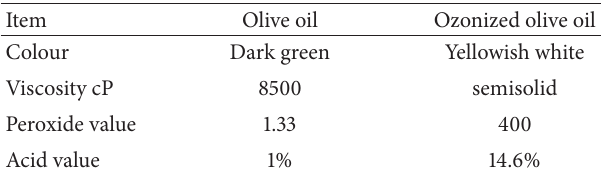
Table 1: The physicochemical parameters of olive oil and ozonized olive